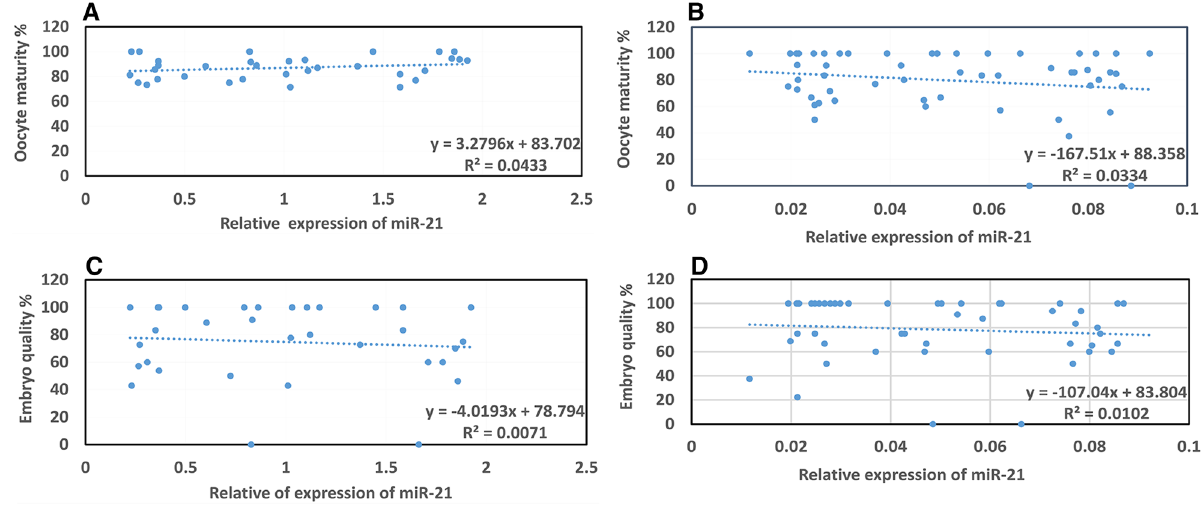
Figure 3. Correlation of the level of miR-21 expression in the serum sample with oocyte maturation (%) and embryo quality (%) in the case and control groups. There was no significant relationship between the rates of miR-21 expression in the serum with oocyte maturity and embryo quality in the case and control groups based on Pearson’s correlation ( p > 0.05). The results are presented as the mean ± SEM. ( A ) Correlation of the level of miR-21 expression in the serum sample with oocyte maturation in the control group. ( B ) Correlation of the level of miR-21 expression in the serum sample with oocyte maturation in the case group. ( C ) Correlation of the level of miR-21 expression in the serum sample with embryo quality in the control group. ( D ) Correlation of the level of miR-21 expression in the serum sample with embryo quality in the case group.